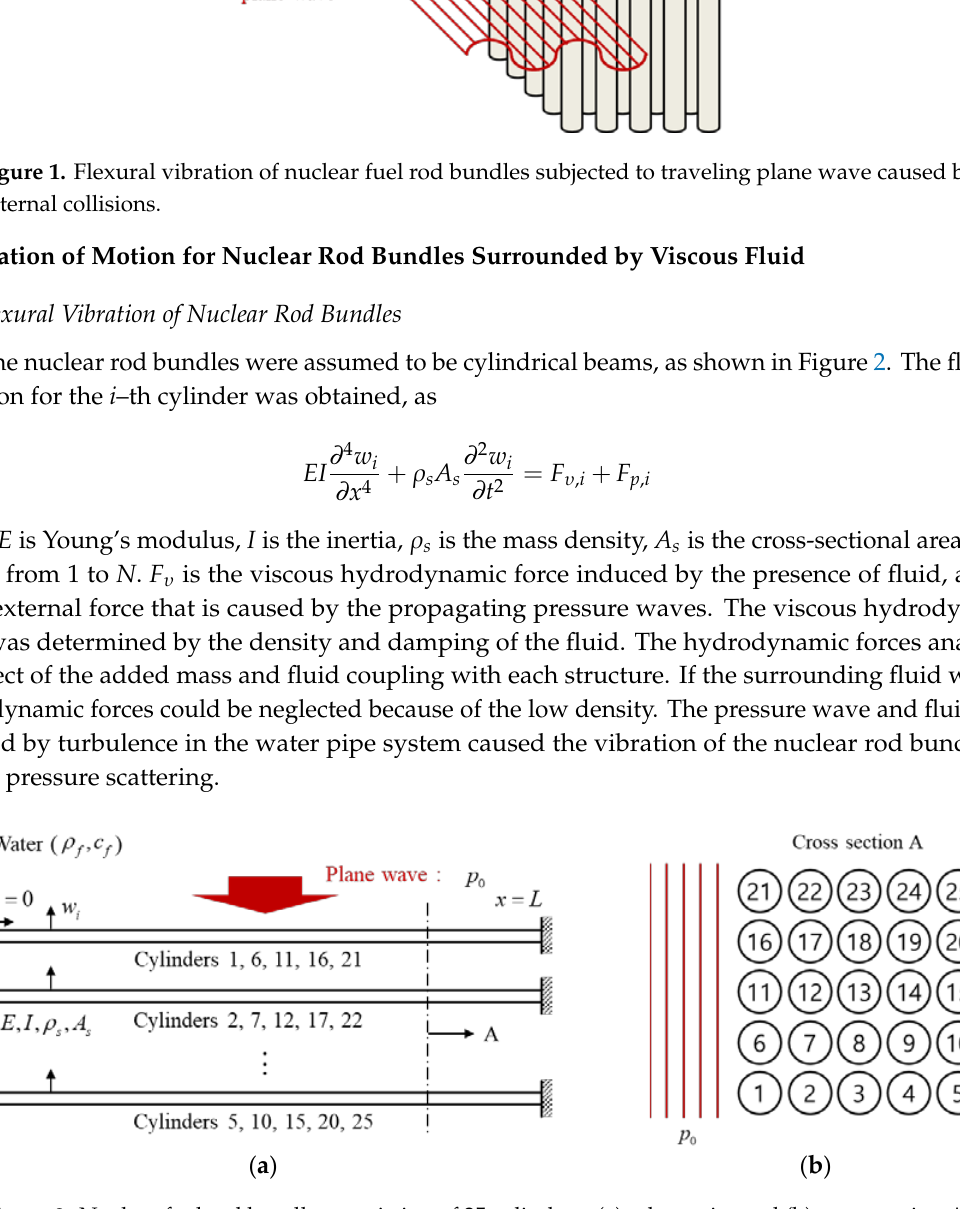
Figure 2. Nuclear fuel rod bundles consisting of 25 cylinders: (a) schematics and (b) cross section A.